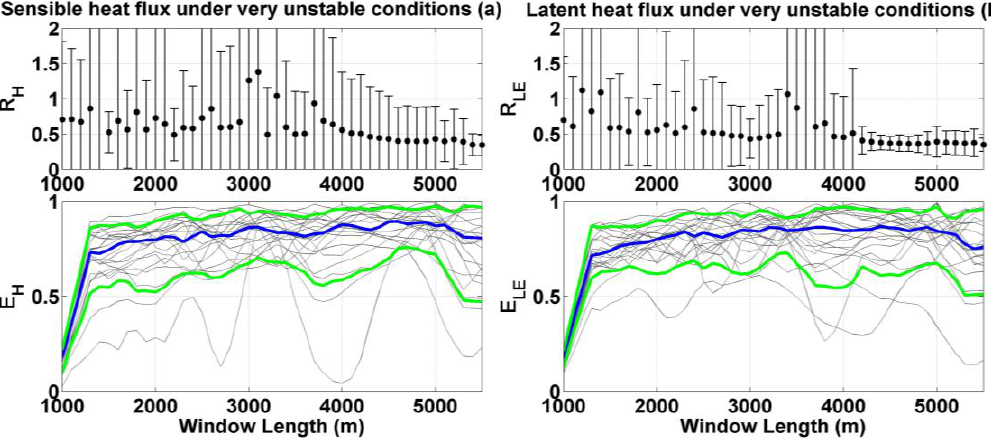
Figure 9. Averaged relative flux uncertainties ( R H , R LE ) with standard deviation ( top panels) and block ensemble averaged non-dimensional flux ( E H , E LE ) ( bottom panels) for sensible heat flux ( a ) and latent heat flux ( b ) under very unstable conditions. In the bottom panel, the solid blue curves represent the median value, while the solid green lines depict the 10th (lower) and 90th (upper) percentiles.